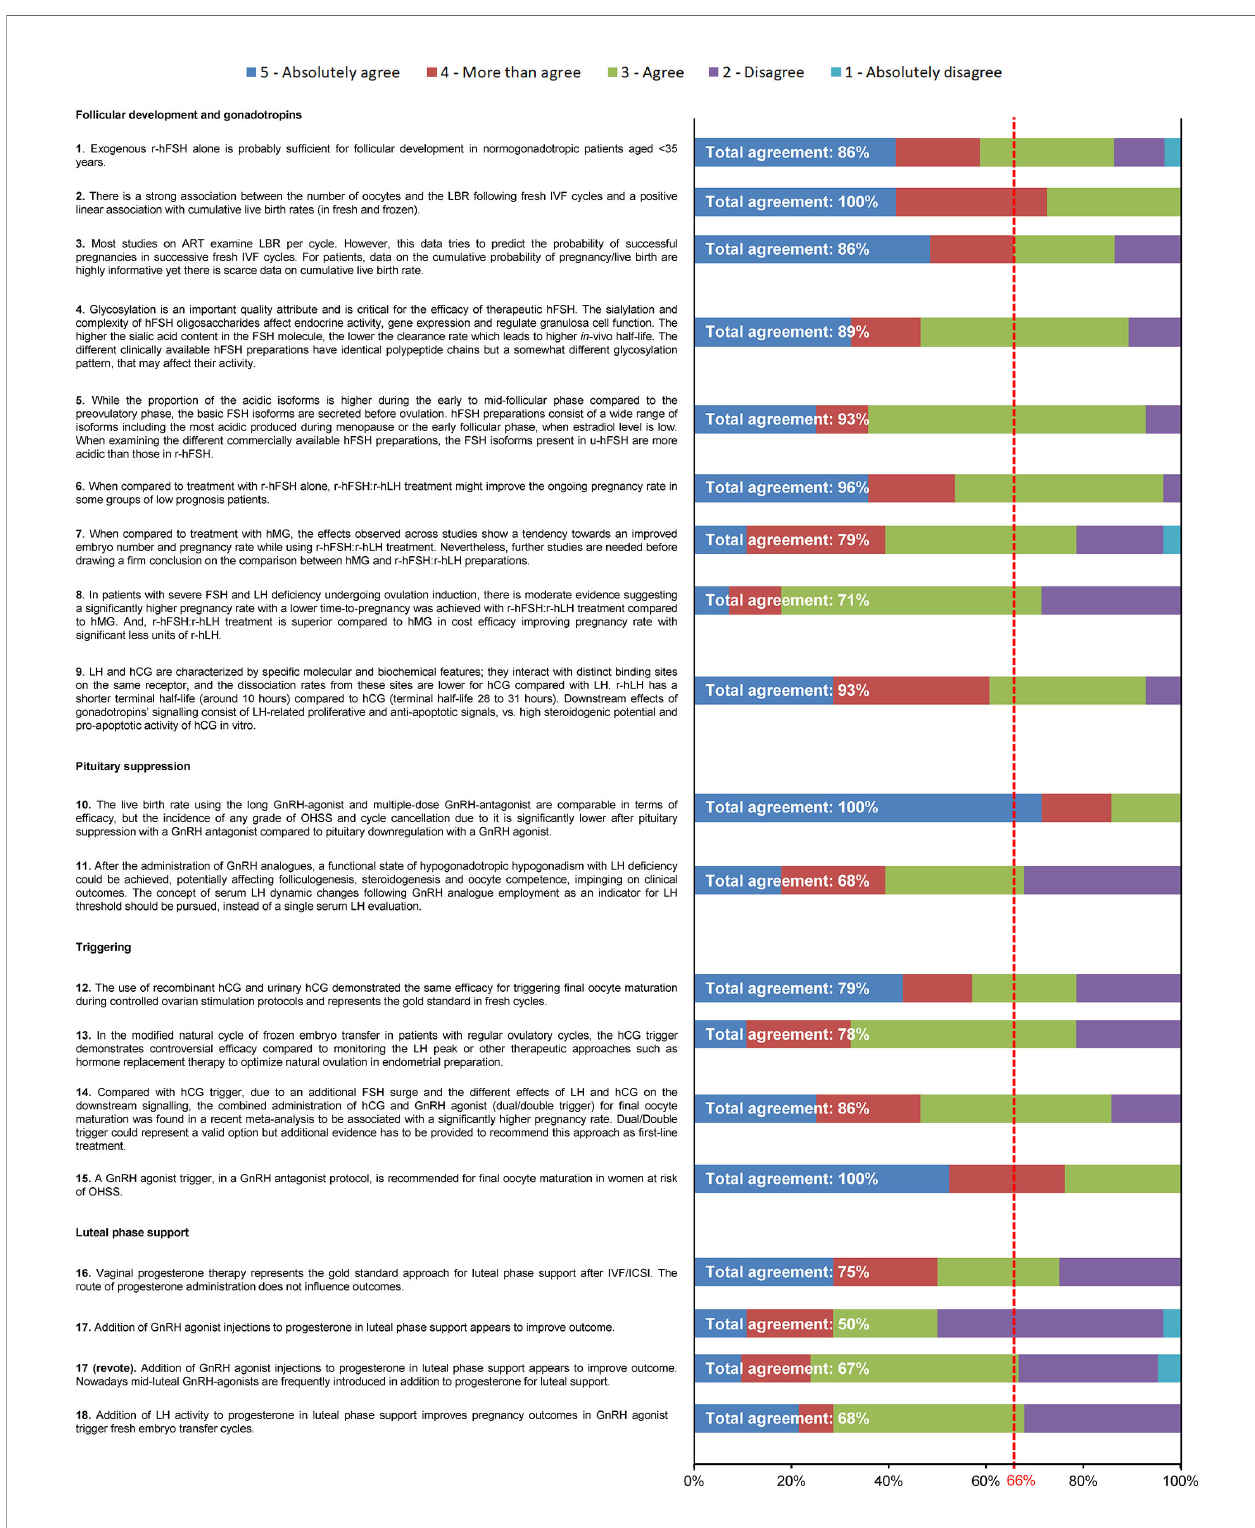
FIGURE 2 | Level of agreement/disagreement with each statement (Step 2). The 35-member Extended Panel voted on their levels of agreement/disagreement with each of the 18 statements using a 5-item Likert scale (1 = absolutely disagree, 2 = disagree, 3 = agree, 4 = more than agree, 5 = absolutely agree). Consensus was considered to have been achieved if the proportion of participants either agreeing with the statement (responding 3, 4 or 5) or disagreeing with the statement (responding 1 or 2) exceeded